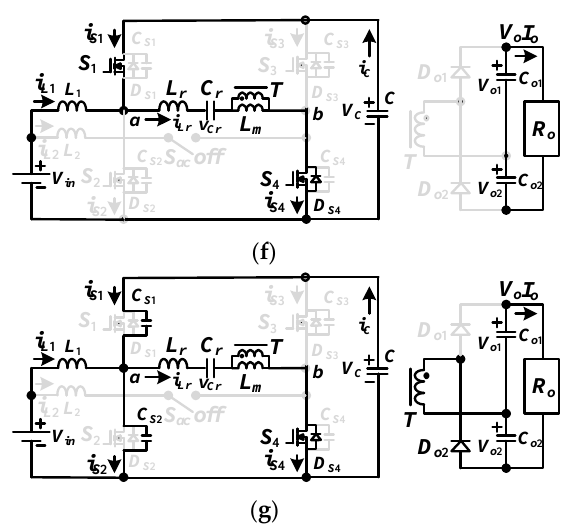
Figure 3. Converter operated at high input voltage mode ( a ) main PWM signals, ( b ) step 1, ( c ) step 2, ( d ) step 3, ( e ) step 4, ( f ) step 5, ( g ) step 6.